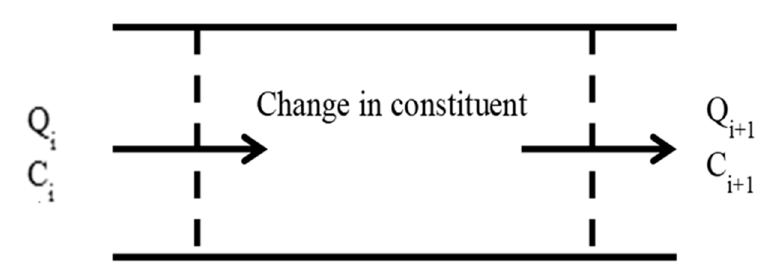
Figure 2. Control volume representing mass balance equation.